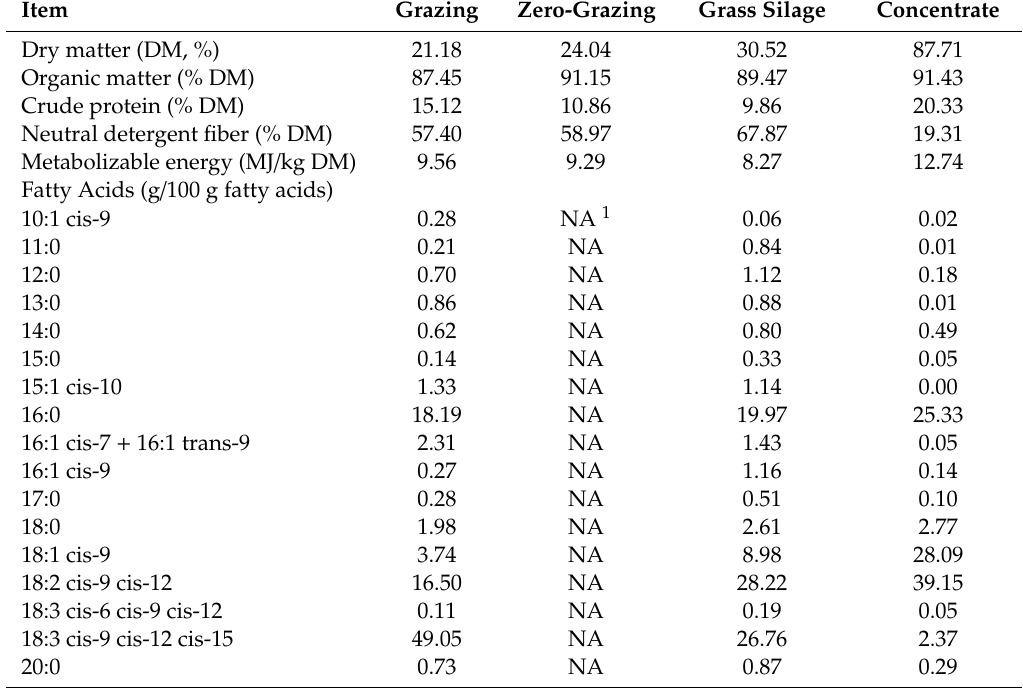
Table 1. Nutritive value, metabolizable energy, fatty acid and antioxidants profiles of forage used in grazing, zero-grazing, grass silage treatments and concentrate used in all treatments. Item Grazing Zero-Grazing Grass Silage Concentrate Dry matter (DM,